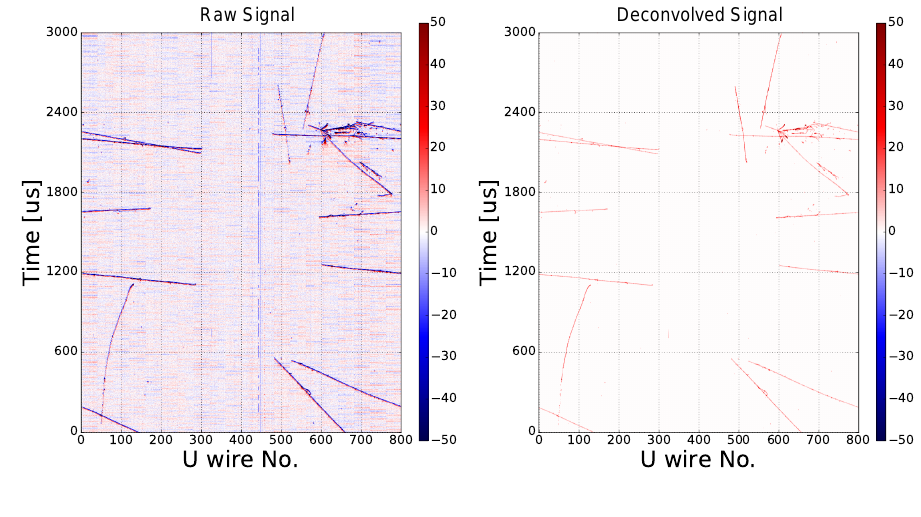
Figure 5. Comparison of raw (left) and deconvolved induction U-plane signals (right) before and after the signal processing procedure from a ProtoDUNE-SP event. The bipolar shape with red (blue) color representing positive (negative) signals is converted to the unipolar shape after the 2D deconvolution.